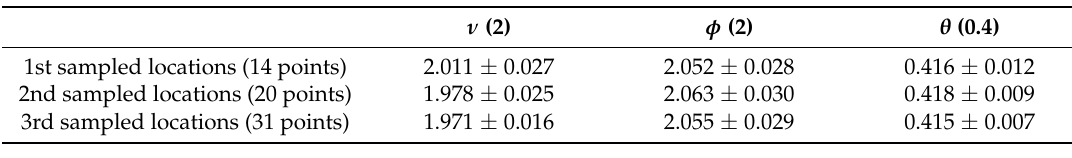
Table 2. Estimated hyperparameters in the covariance function for the test problem. The given values are denoted in the parentheses.